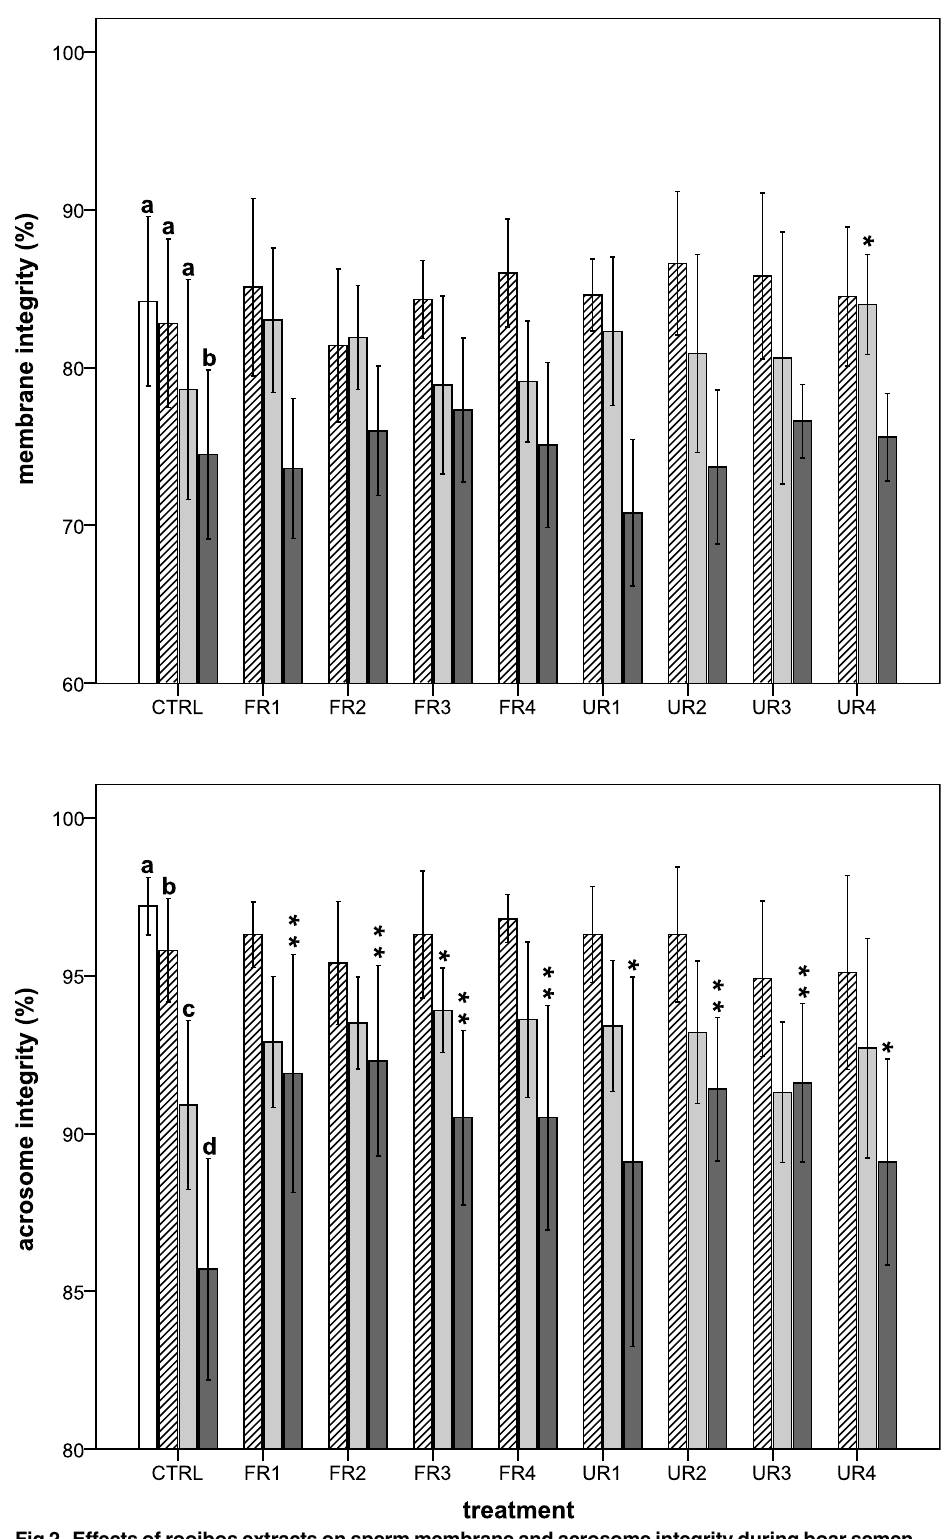
Fig 2. Effects of rooibos extracts on sperm membraneand acrosomeintegrity during boar semen storage. White bars = 0 h; diagonallines bars = 2 h; light grey bars = 48 h; dark grey bars = 96 h. Different letters indicate significantdifferences ( P < 0.05) among times for the control group. The asterisks indicate